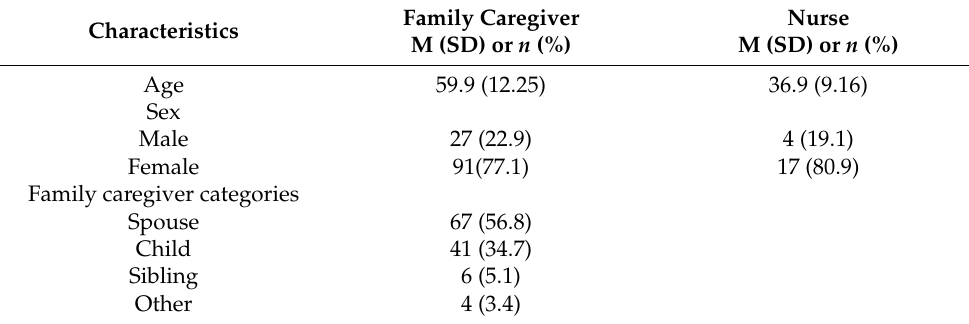
Table 1. Characteristics of family caregivers and nurses.